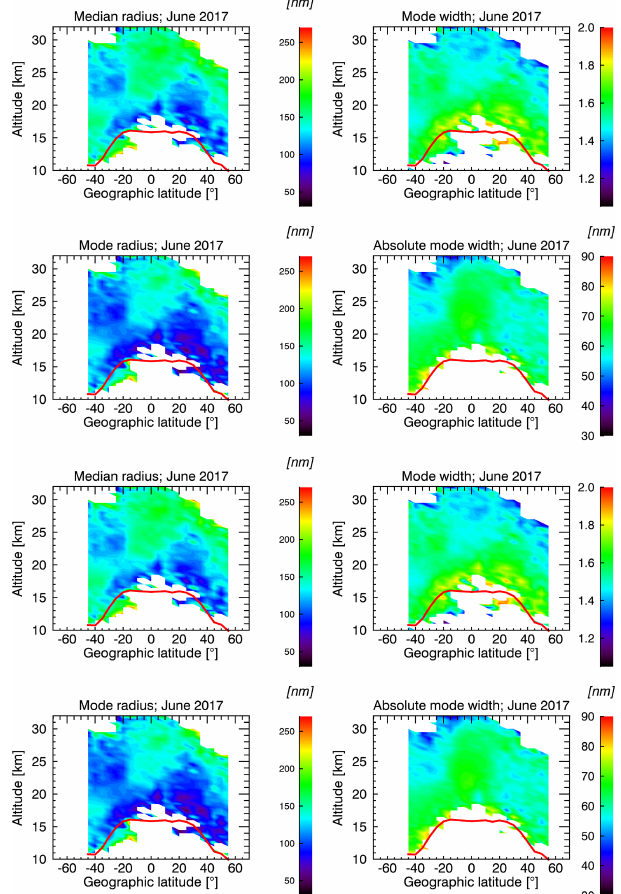
Figure 6. Monthly means of median radius, mode width, mode ra- dius, absolute mode width, extinction coefficient at 449nm, extinc- tion ratio at 449 and 756nm, number density and effective radius for June 2017 with 5 ◦ latitude bins. The red line indicates tropopause